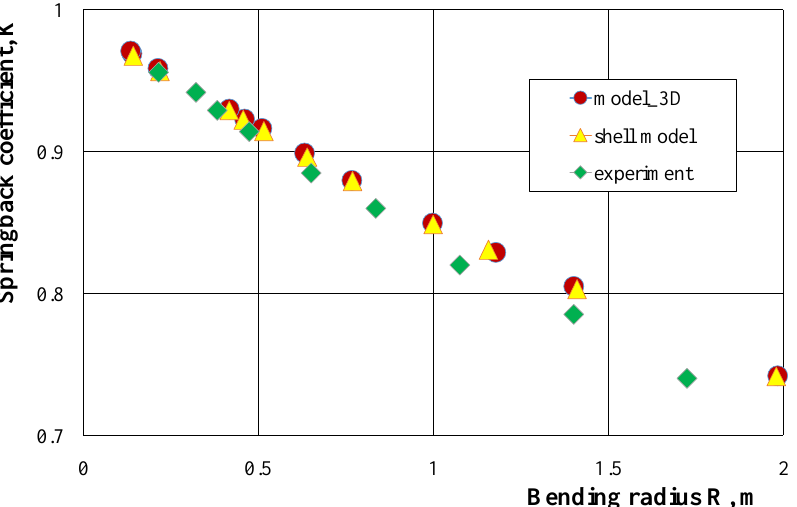
Figure 5. Comparison of the springback characteristics of a square tube with the dimensions of 25 × 25 × 2.5 mm determined on the basis of the results of experimental tests and two FE models.